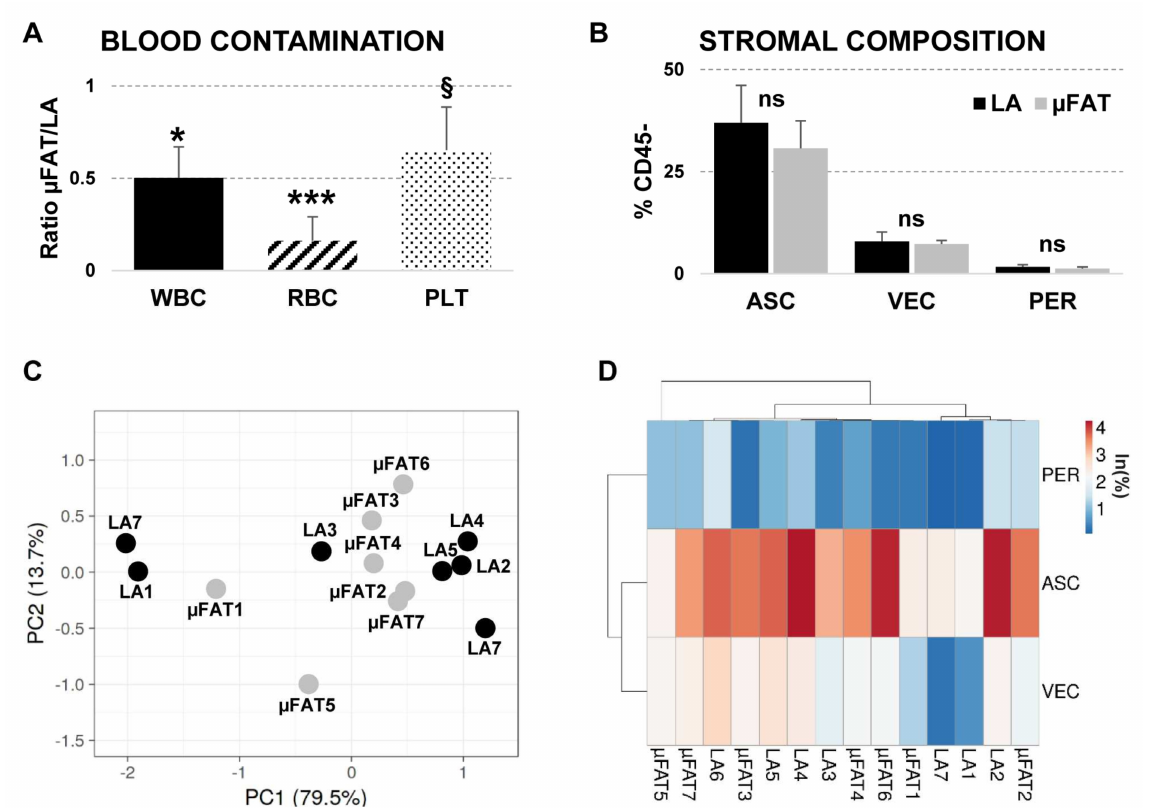
Figure 2. Cell composition of lipoaspirate (LA) and microfragmented ( µ FAT) tissues. ( A ) Blood elements as white blood cells (WBC), red blood cells (RBC) and platelets (PLT) were counted with an haematology analyzer. N = 7. § for p -value ≤ 0.1, * p -value ≤ 0.05 and *** p -value ≤ 0.001. ( B ) Adi- pose stromal cells (ASC, CD31 − CD34 + CD90 + CD105 Low CD146 − ), vascular endothelial cells (VEC, CD31 + CD34 + CD90 + CD105 − /L CD146 + ) and pericytes (PER, CD31 − CD34 − CD90 + CD105 − CD146 + ) were detected by flow cytometry on the CD45 − population. N = 7. ns for not significant p -value. ( C , D ) Principal component analysis (PC = Principal Component in panel C) and hierarchical clus- tering obtained with % values of the different CD45 − populations (ln transformed) identified by flow cytometry and presented in panel B. Clustering options for heat map were distance for rows— correlation, method for rows—average and tree ordering for rows—tightest cluster